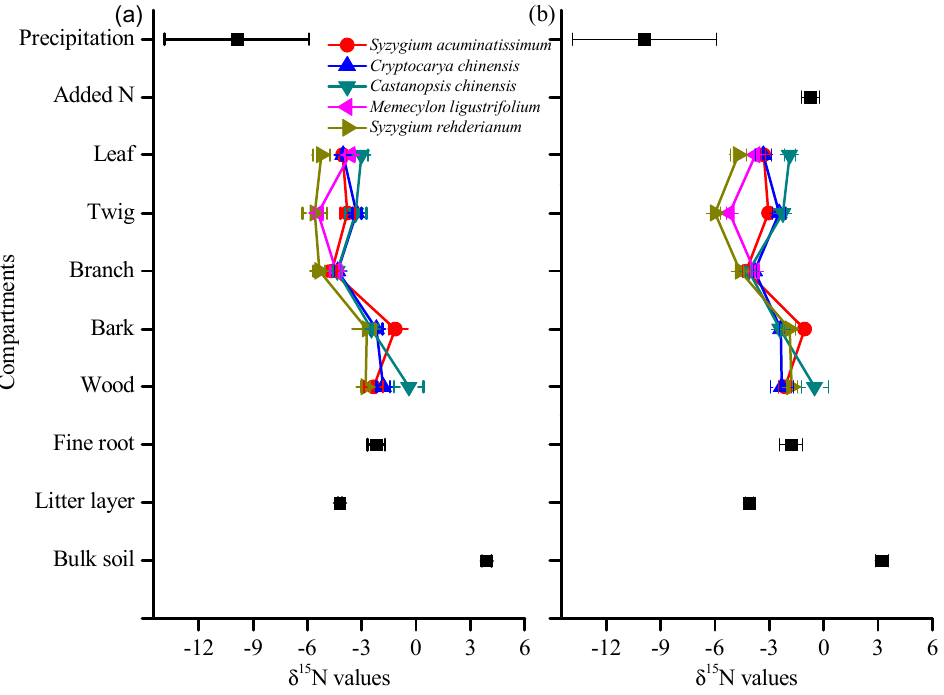
Figure 2. δ 15 N values of tree compartments of dominant co-occurring tree species in Dinghushan Biosphere Reserve (DHSBR) sampled prior to 15 N addition: ( a ) in the control plots; and ( b ) in the N-plots including the δ 15 N values of the N source end points (precipitation, added N and bulk soil). δ 15 N of N in precipitation are from Gurmesa (2016) [28]. Error bars indicate SE ( n = 3).